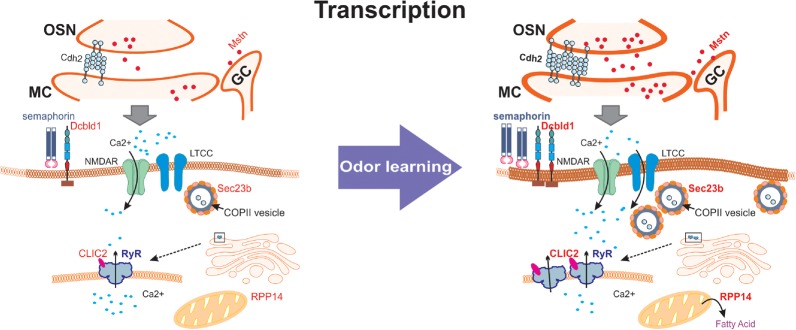
Model of training-induced plasticity changes predicted by up-regulation of transcription in five functionally characterized proteins in the microarray. The protein-coding genes in red support structural changes such as increased connectivity (Dcbdl1, Sec23b), increased synaptic membrane (Sec23b), increased ryanodine receptor clustering (Clic2), increased fatty acid production for mitochondrial biogenesis (Rpp14), and increased excitatory input to granule cells (Mstn).